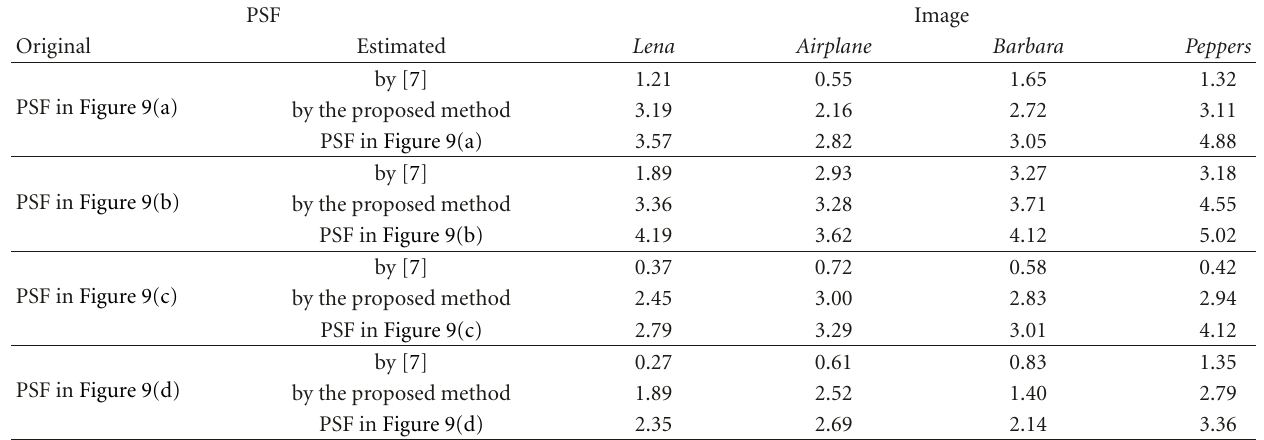
Figure 9: Four sample PSFs with the following parameters. (a) L = 9, θ = 135 ◦ , and N = 3. (b) L = 11, θ = 30 ◦ , and N = 3. (c) L = 7, θ = 60 ◦ , and N = 5. (d) L = 13, θ = 90 ◦ , and N = 5. Table 1: ISNR(dB) comparison of deblurred